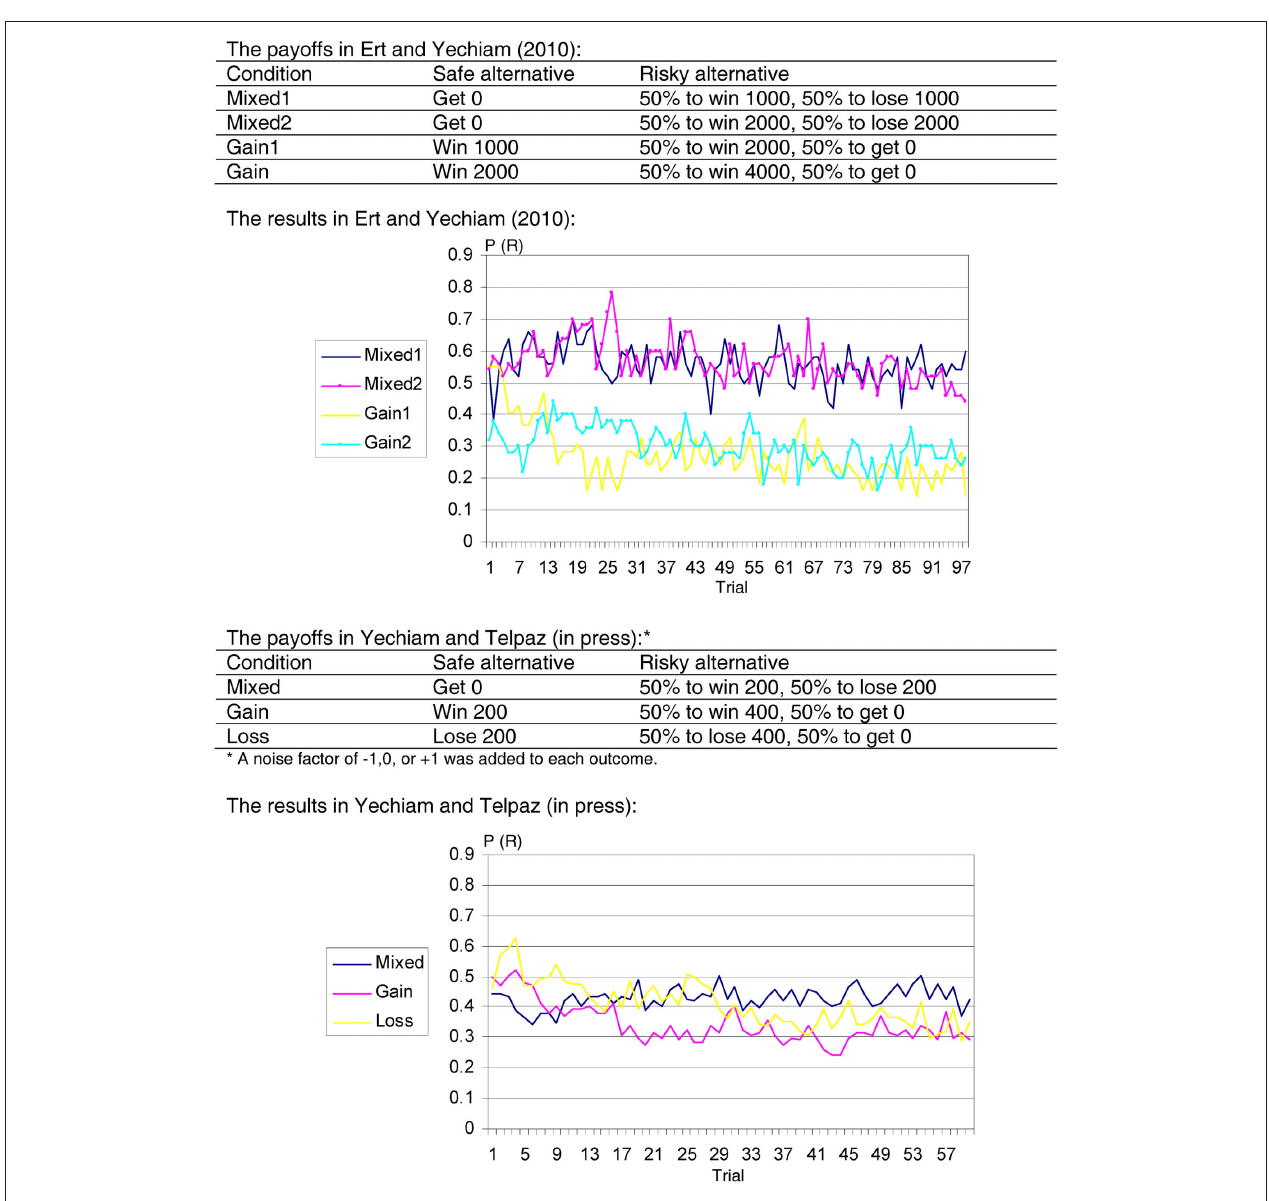
the mean proportion of selections from the risky alternative in each trial [P(R)] in different conditions. The participants take less risk over time when payoffs are predominantly gains or losses but not in mixed gains and